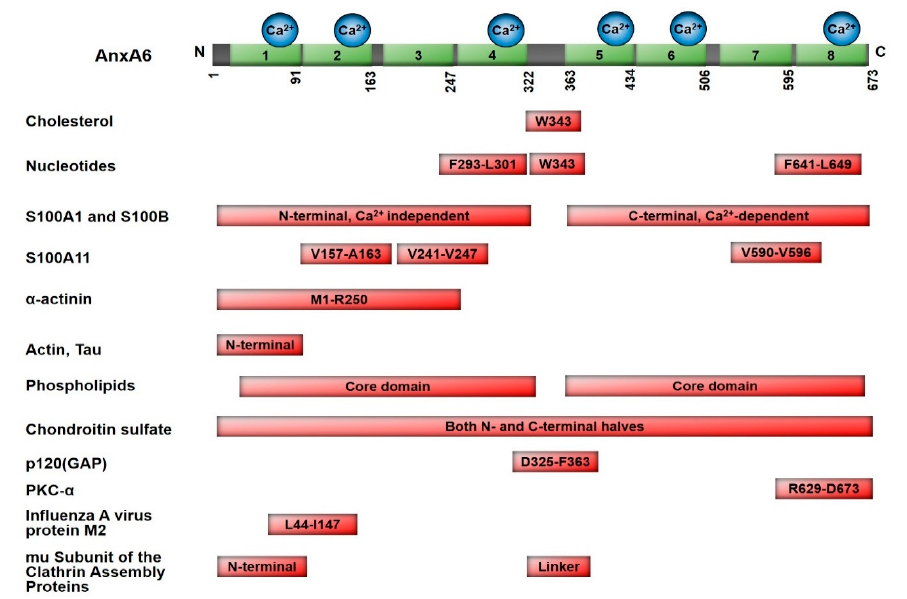
Figure 1. Putative binding domains of some AnxA6 interacting partners. The primary structure of AnxA6 showing the eight annexin repeats and the six potential Ca 2 + binding sites. The putative binding domains of known interactors including phospholipids, cholesterol, nucleotides and other proteins relative to the primary structure of AnxA6 isoform 1 (NM_001155.5; NP_001146.2; 673 amino acid residues) are indicated (not to scale). See text for further details.